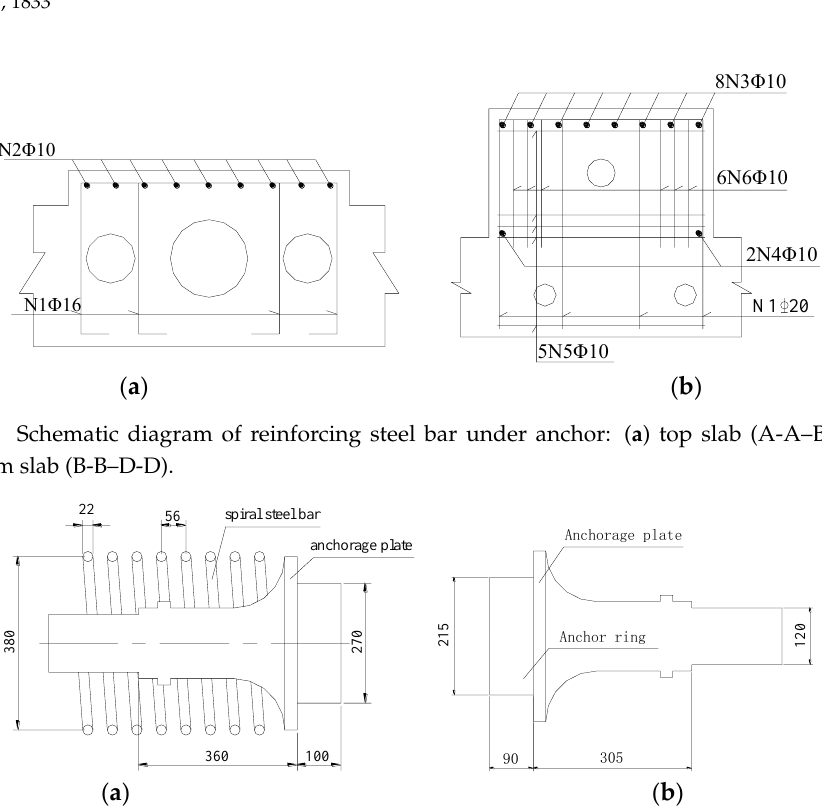
Figure 6. The test section of the bottom slab specimen (unit: mm)